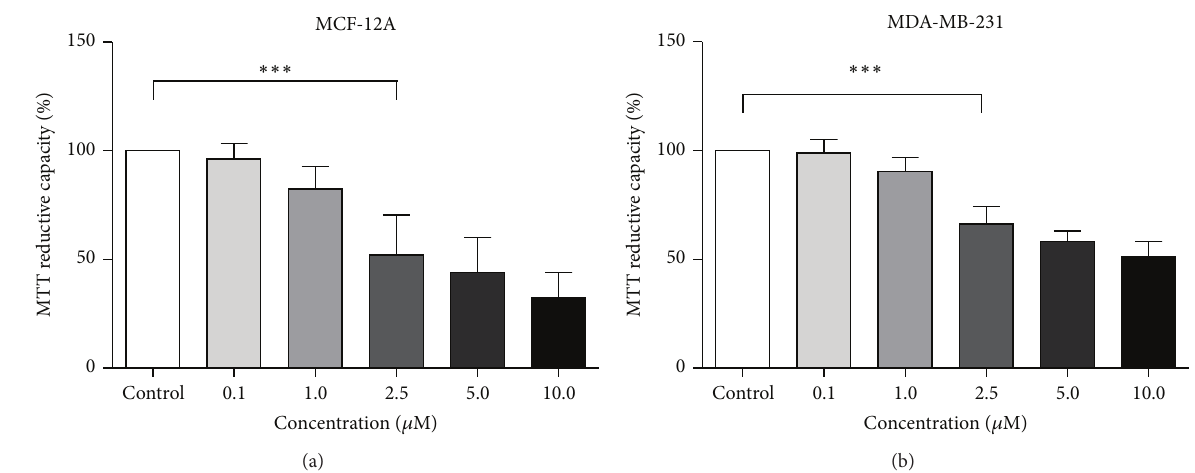
Figure 3: The effect of various concentrations of doxorubicin on the viability of nontumourigenic breast epithelial MCF-12A cells (a) and triple negative breast cancer cells MDA-MB-231 (b). MCF-12A and MDA-MB-231 cells were incubated in 0 (control), 0.1, 2.5, 5.0, and 10.0 𝜇 M doxorubicin for 24 hours. Cell viability was assessed using the MTT assay. Values are expressed as a percentage of the control and presented as mean ± SEM ( 𝑛 = 3 ). ∗ ∗ ∗ = 𝑃 < 0.0001 versus